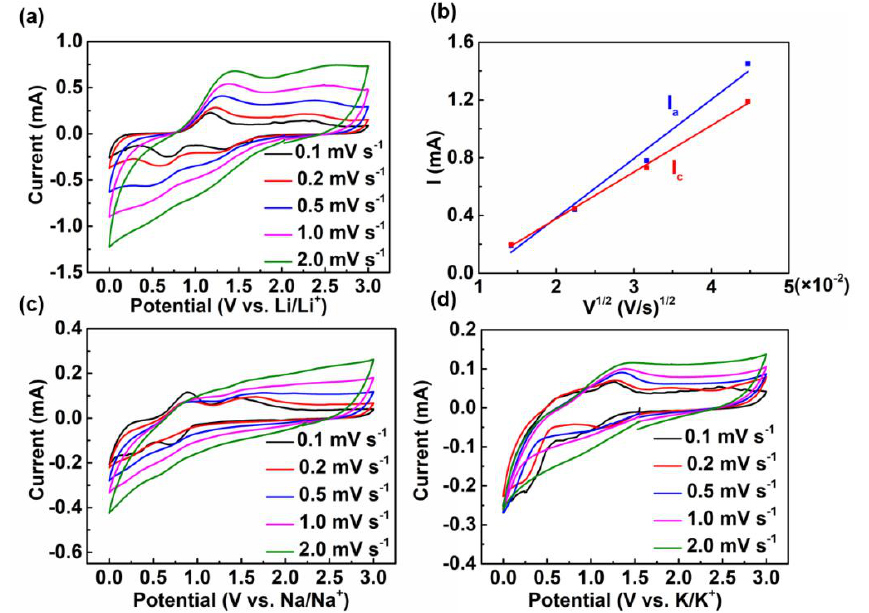
Figure 5. ( a ) Cyclic voltammetry (CV) curves of LIBs at different scan rates. ( b ) Cathodic and anodic peak currents versus the square root of scan rate, data are obtained from part ( a ). ( c ) CV curves of SIBs at different scan rates. ( d ) CV curves of KIBs at different scan rates.